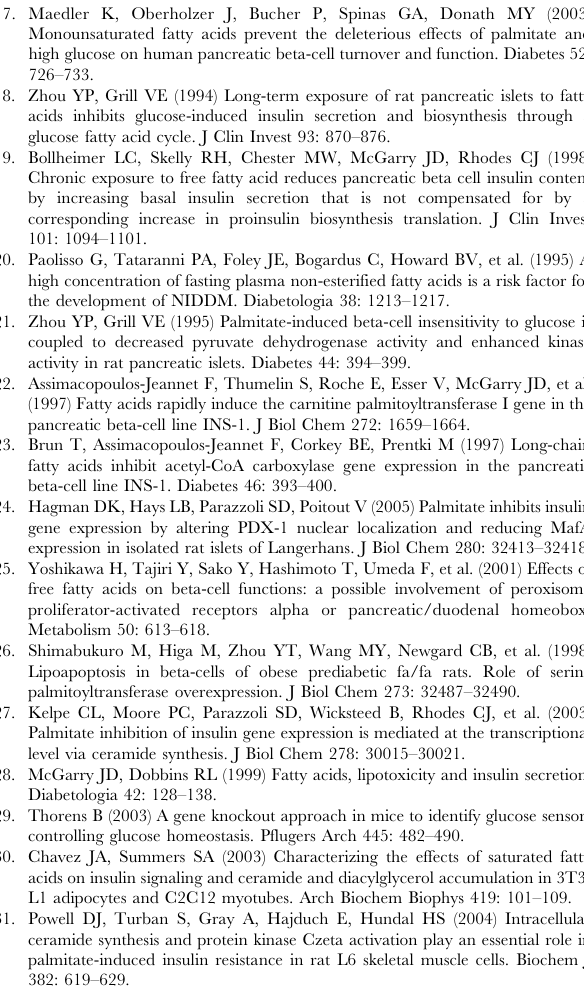
Figure S2 Palmitate inhibits glucose-induced calcium oscillations. MIN6 b cells were incubated with 0.4 mM palmitate for 48 h. Glucose was then added for 1 h for stimulation before assessment of calcium content. Briefly, during the 1